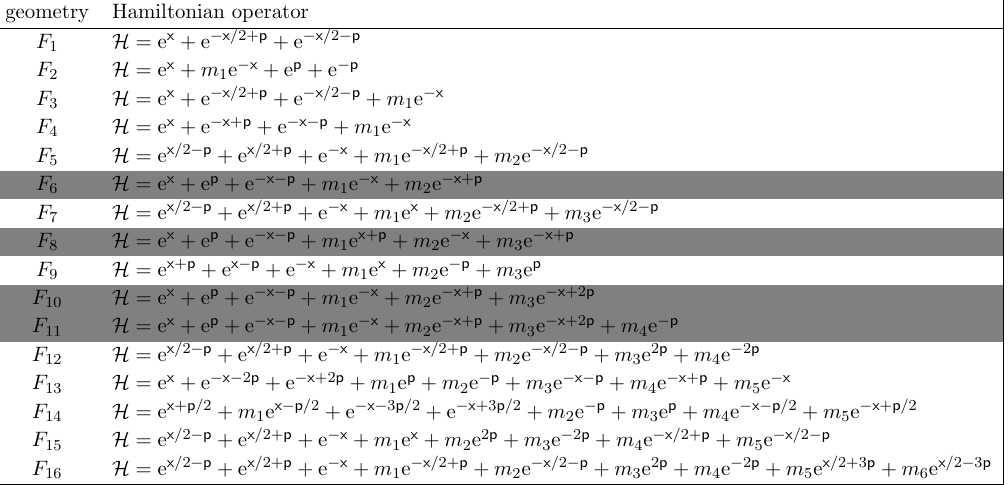
Table 1 . Hamiltonian operators associated to the 16 re(cid:13)exive Newton polygons arranged in such a way that with appropriate values of mass parameters they are p -parity invariant, except for F 6 ; F 8 ; F 10 ; F 11 which are marked out in